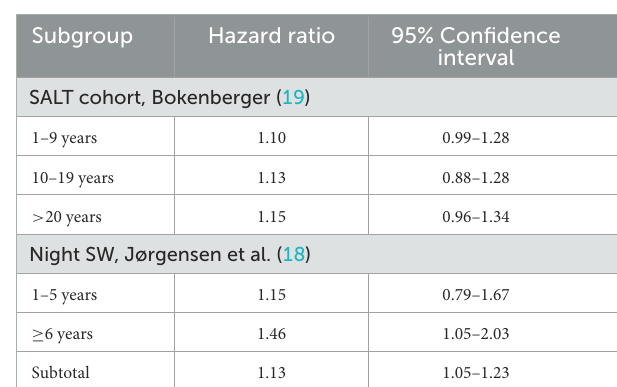
TABLE 3 Subgroup analysis of hazard ratio based on night shift work for over 1